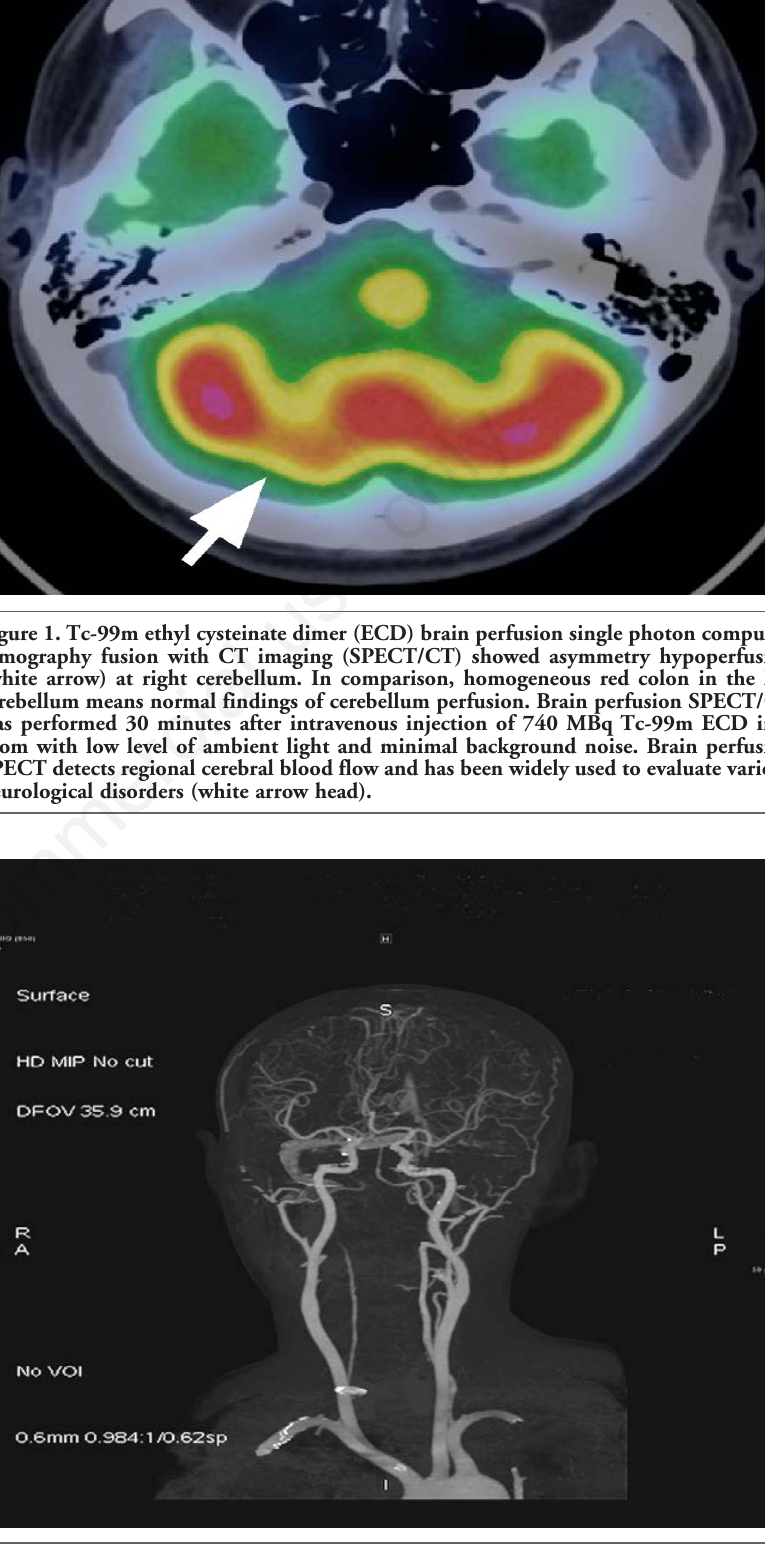
Figure 2. Cerebral computed tomographic angiography: right side vertebral artery long segmental narrowing and flow avoid from V2 to V3 (red arrow